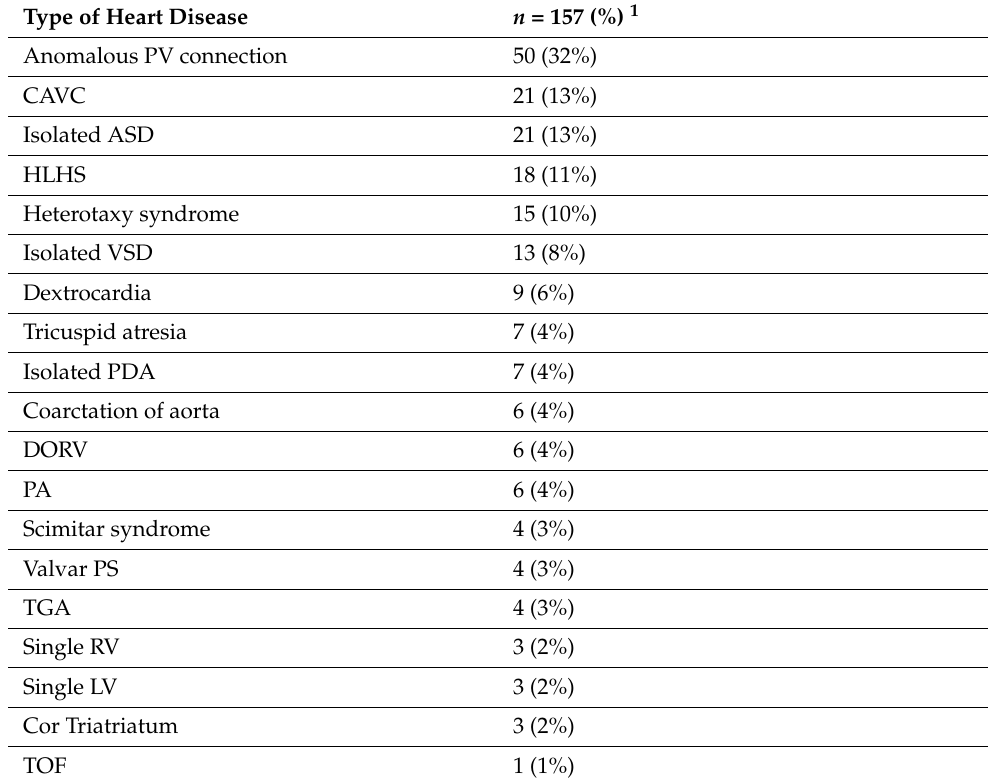
Table 4. Structural heart disease in PVS patients.